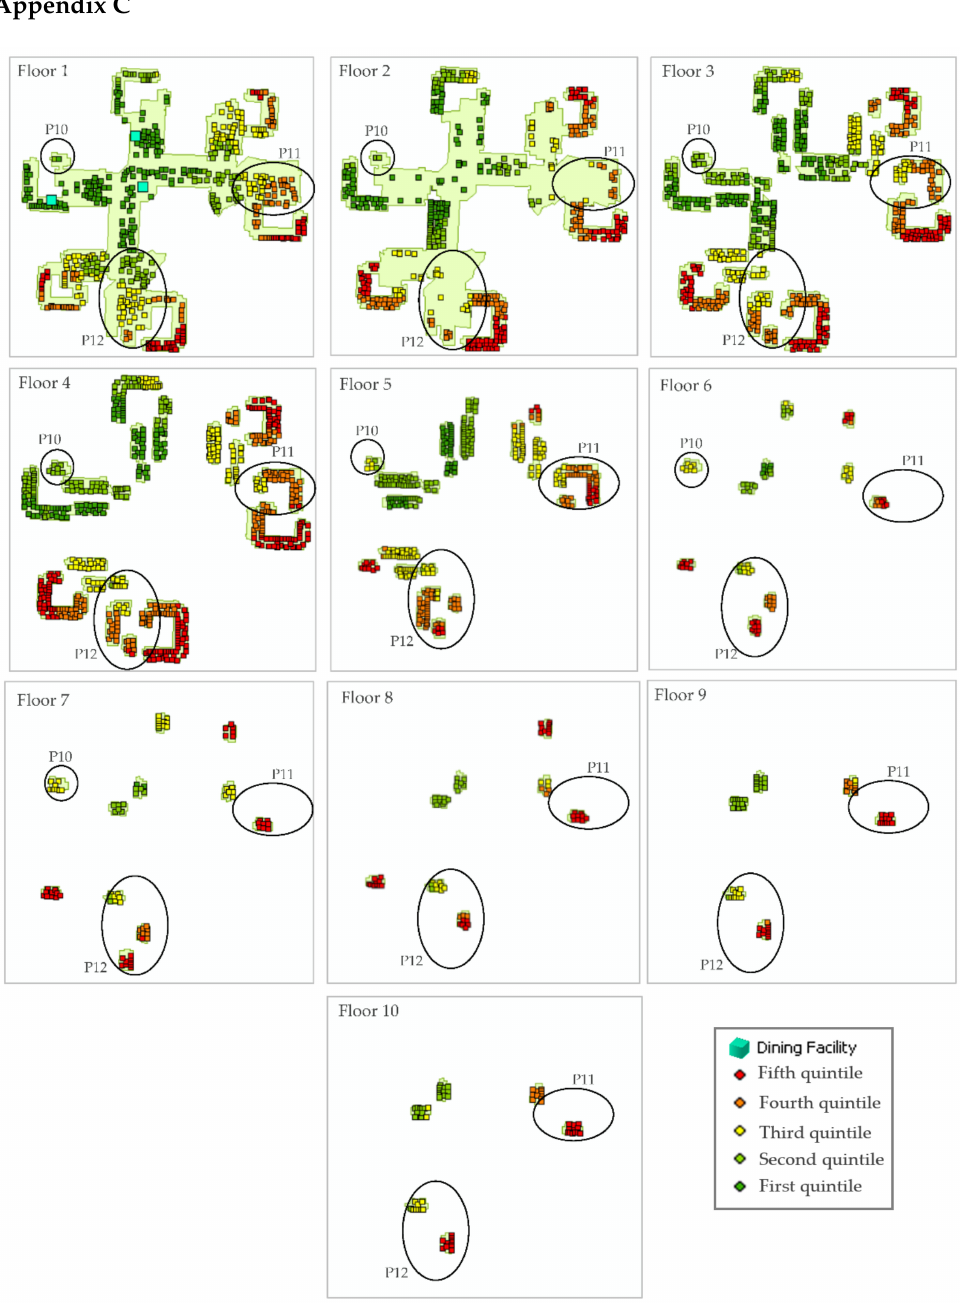
Figure A3. Metric accessibility to three facilities for different floors: classification in